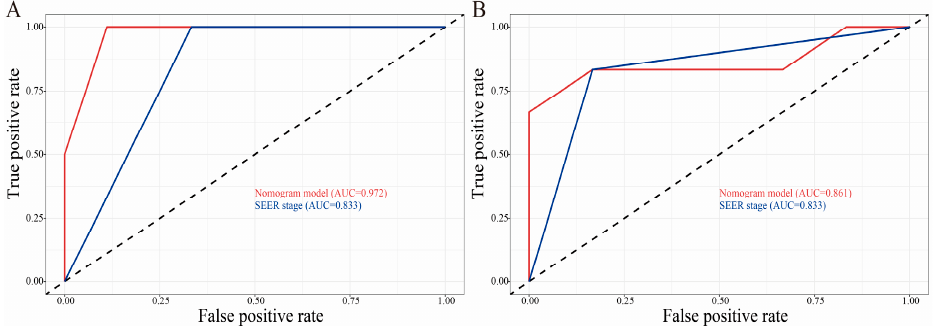
12 months. In CSS analysis, the C-indexes were 0.777 (95% CI: 0.608–0.946). In addition, the AUCs of 6- and 12-month (0.972 and 0.861) nomograms were greater than the SEER stage system (0.833 and 0.833) (Figure 7). The results suggested that our prediction model had good applicability and predictive performance in external data.